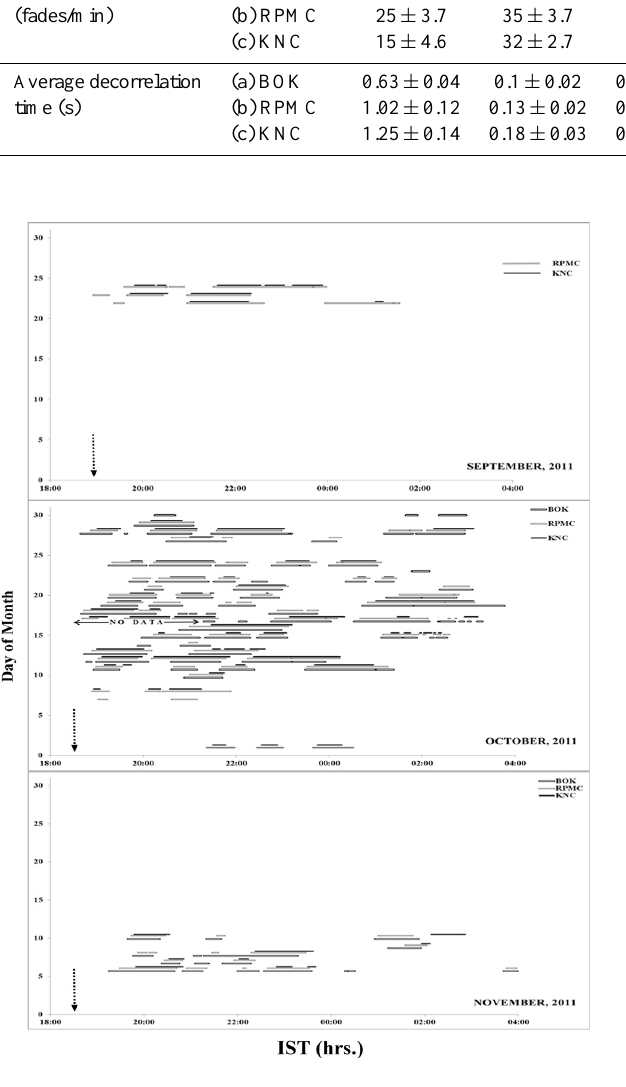
Fig. 4. Horizontal bar diagram showing date-wise distribution of scintillations ( S 4 > 0 . 2) at VHF frequency from three locations – BOK, RPMC and KNC – during the observation period. The ver- tical arrows on time axis represent subionospheric (VHF) sunset